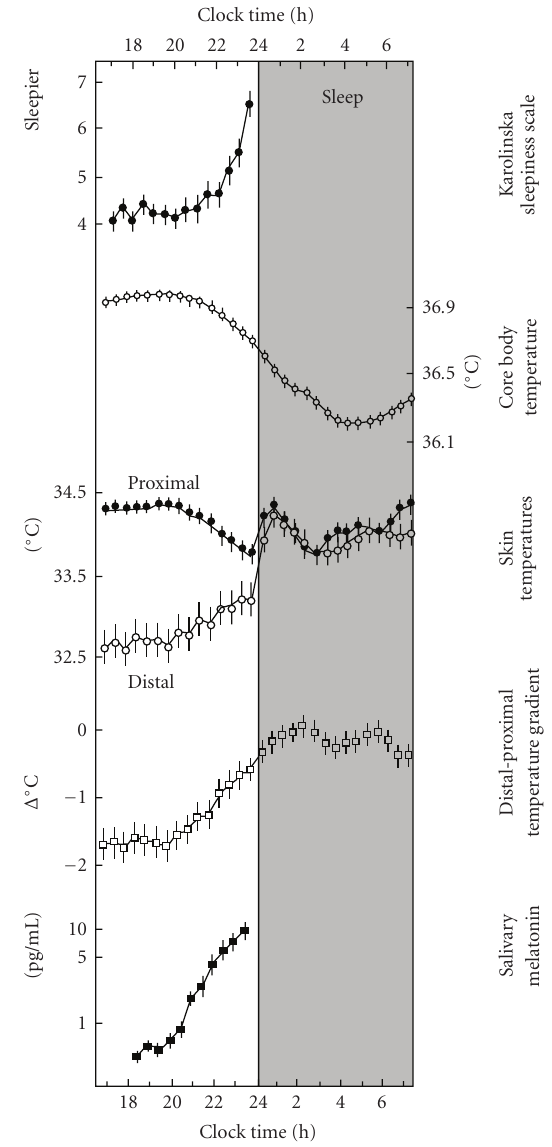
Figure 3: The relationship between melatonin secretion, body temperature and sleepiness. The onset of melatonin secretion during the early night causes an increase in heat loss at the extremities (i.e., rising distal skin temperature, and distal-proximal temperature gradient) and a drop in core body temperature, followed by an increase in sleepiness. From